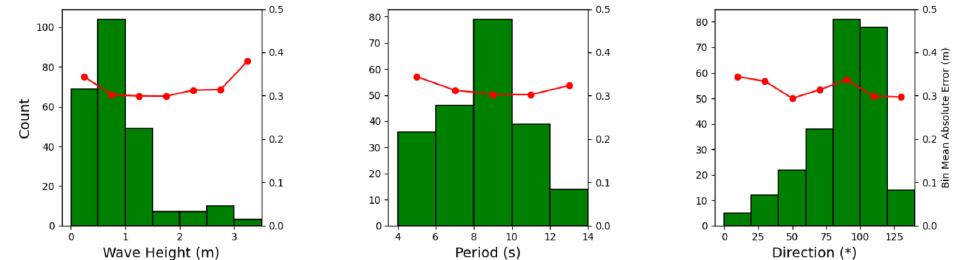
Figure 10. Model error across different wave conditions. ( a ) shows the mean error versus the wave height. ( b ) shows the mean error versus the wave direction. ( c ) shows the mean error versus the wave